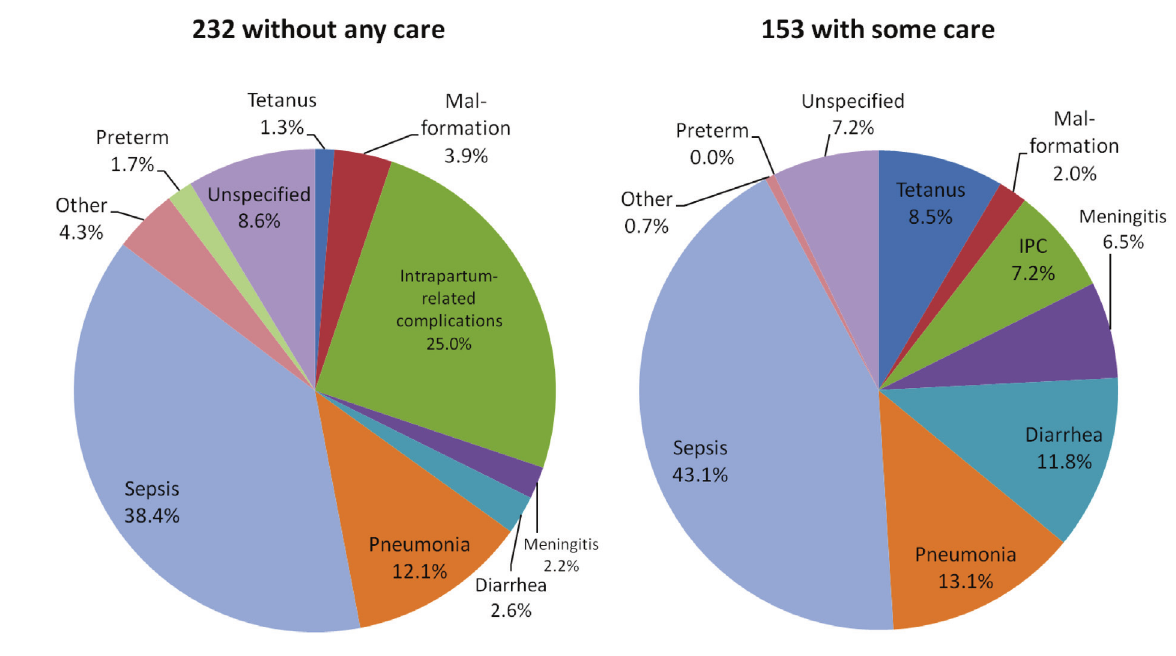
Figure 4. Expert algorithm, hierarchical verbal autopsy causes of death for 385 neonates born at home or left the delivery facility alive, with and without any care given or sought from home, Niger, 2007–2010. IPC – intrapartum-related